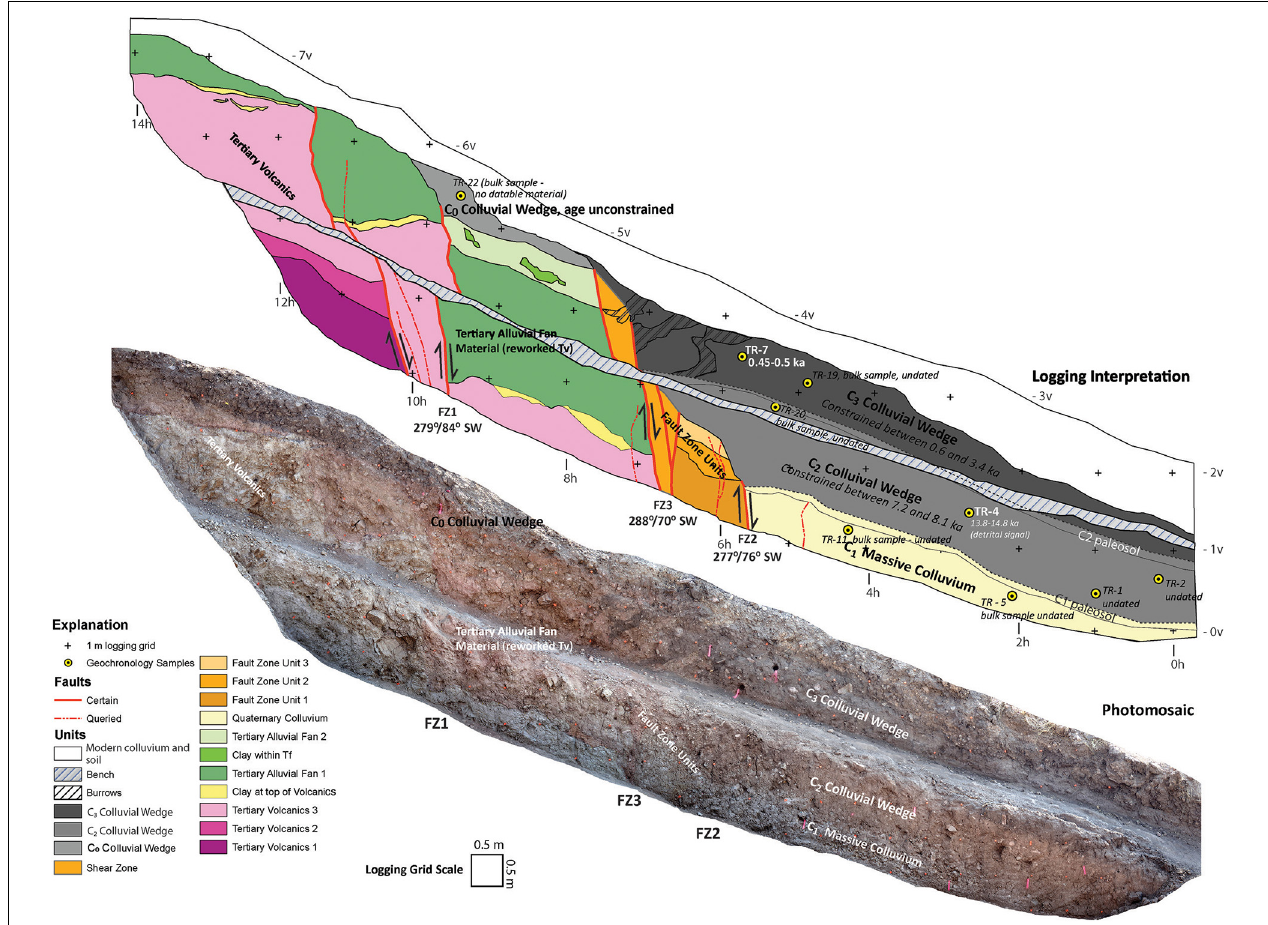
FIGURE 3 | The east wall of Trench One North (T1N) presents evidence for three earthquake-produced colluvial wedges (C 0 , C 2 , and C 3 ) along three fault zones. Age ranges are constrained for the C 2 and C 3 events. Sample TR-7 (0.3 – 0.5 ka) on this wall is helpful for constraining the age of the event associated with C 3 ( Figures 7 , 8 and Table 1 ). Other samples constraining these events are found on the west wall ( Figure 4 and Table 1 ). Undated samples and samples that were not included in the event age modeling are shown in italics and smaller